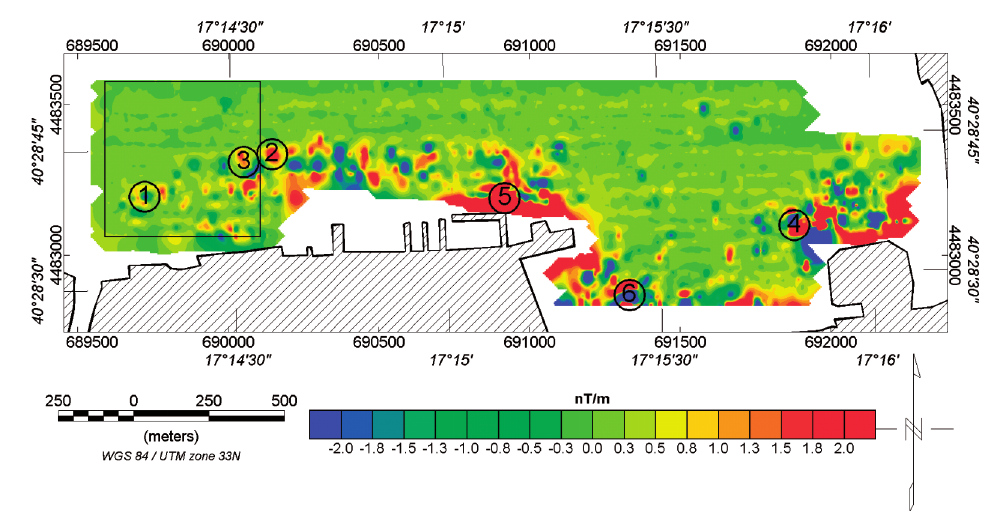
Fig. 2. Magnetic gradient: measured component in the north-south direction; the circles identify the actual ob- ject found on the seabed and listed in table I. The whole analytical magnetic signal was computed inside the box on the left. This is plotted in fig.